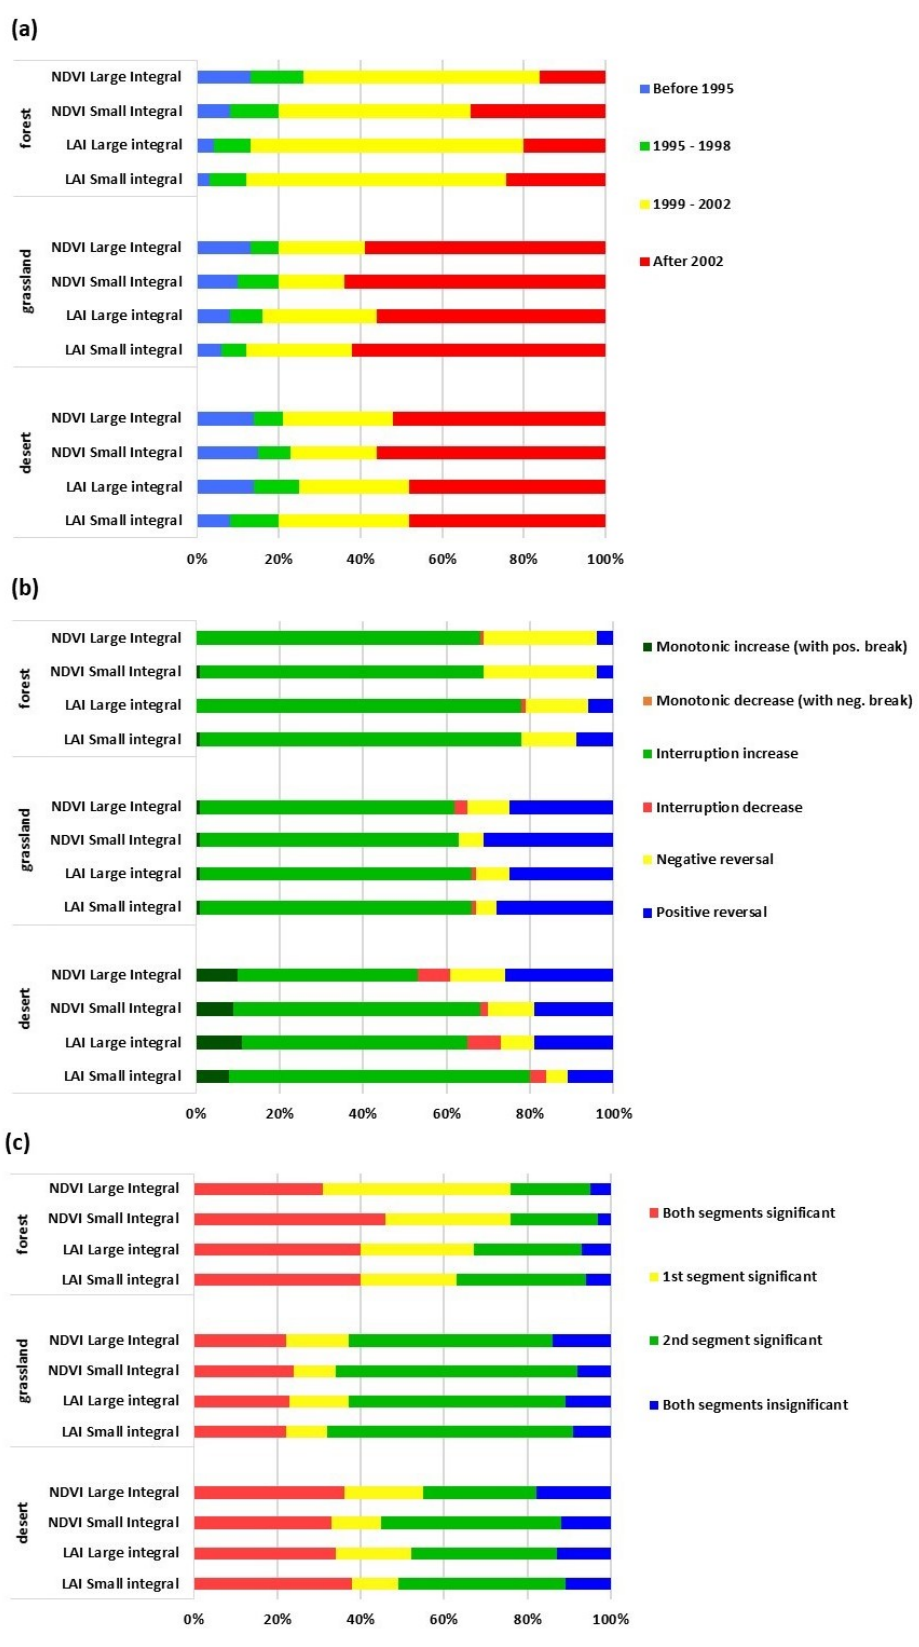
Figure 6. Statistic per biome on to the ( a ) the type, ( b ) the timing, and ( c ) the significance of the trend shifts in NDVI and LAI integrals during the period 1982–2016. Statistics are expressed as a percentage of an area within each biome. Pixels without trend breaks are not considered.